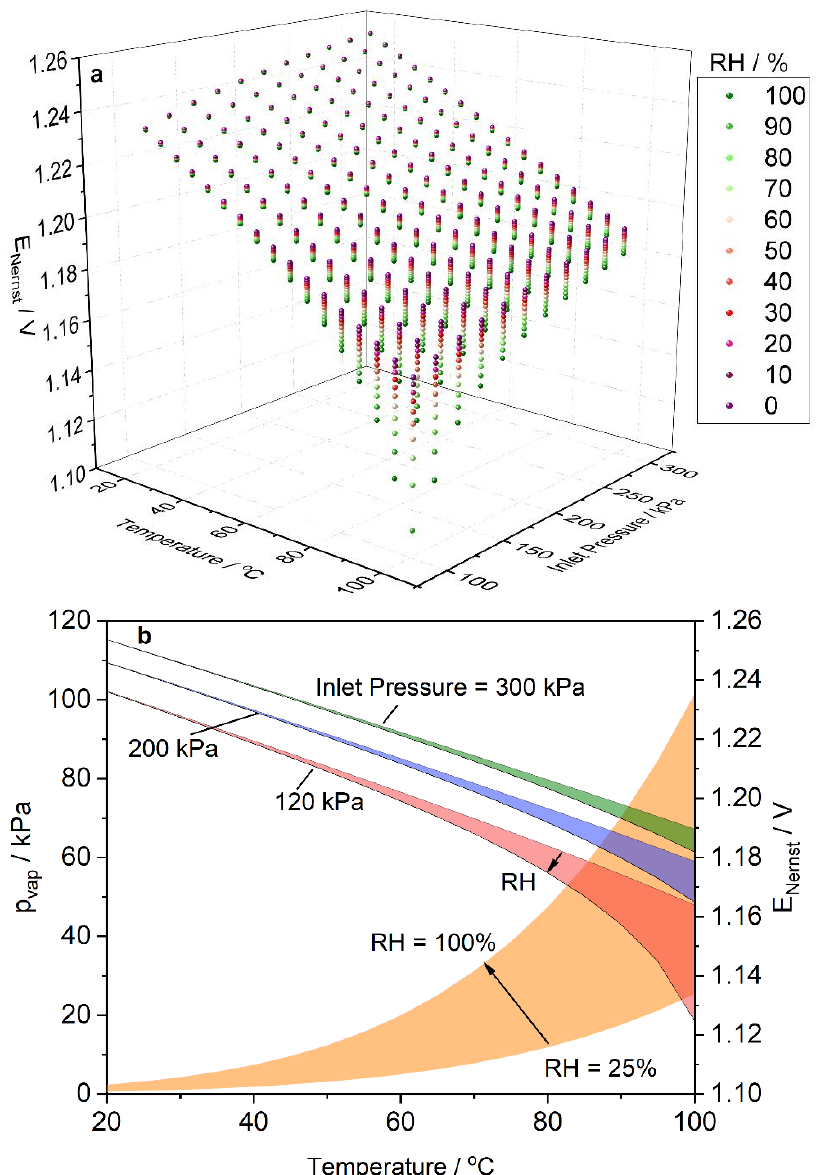
Figure 2. ( a ) The Nernst potential, E Nernst calculated in the temperature range 20–100 ◦ C, inlet pressure range 101.3–300 kPa and RH range 0–100%. Product H 2 O in the liquid form only is assumed. ( b ) The effect of RH on p vap and the corresponding effect on E Nernst